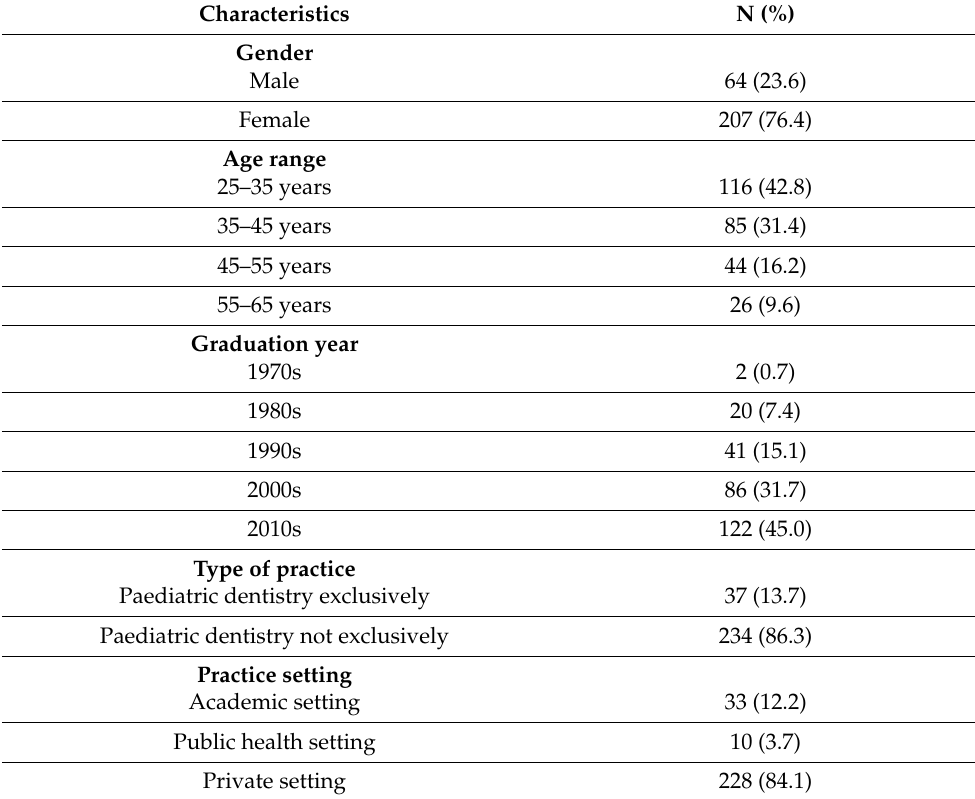
Table 1. Sociodemographics analysis of respondents who participated in the survey N =